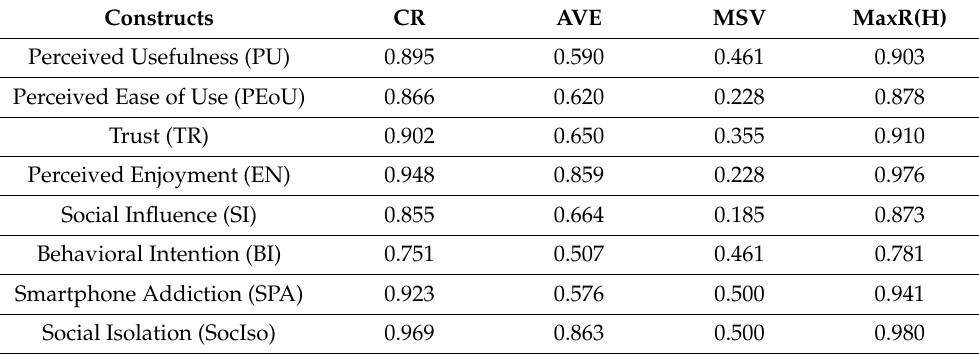
Table 7. Convergent validity indicators.